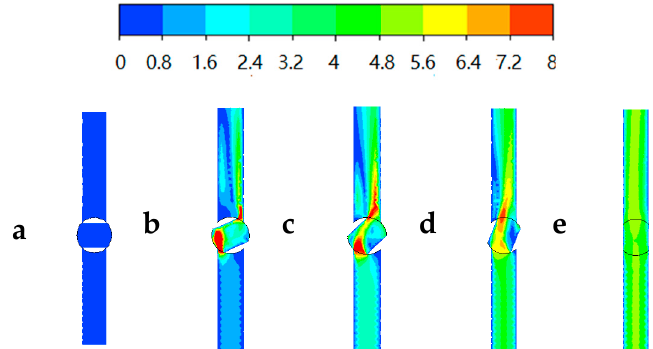
Figure 17. The velocity evolution of the valve during the valve opening process: ( a ) t = 8 s, ( b ) t = 8.1 s, ( c ) t = 8.2 s, ( d ) t = 8.3 s, ( e ) t = 8.4 s.